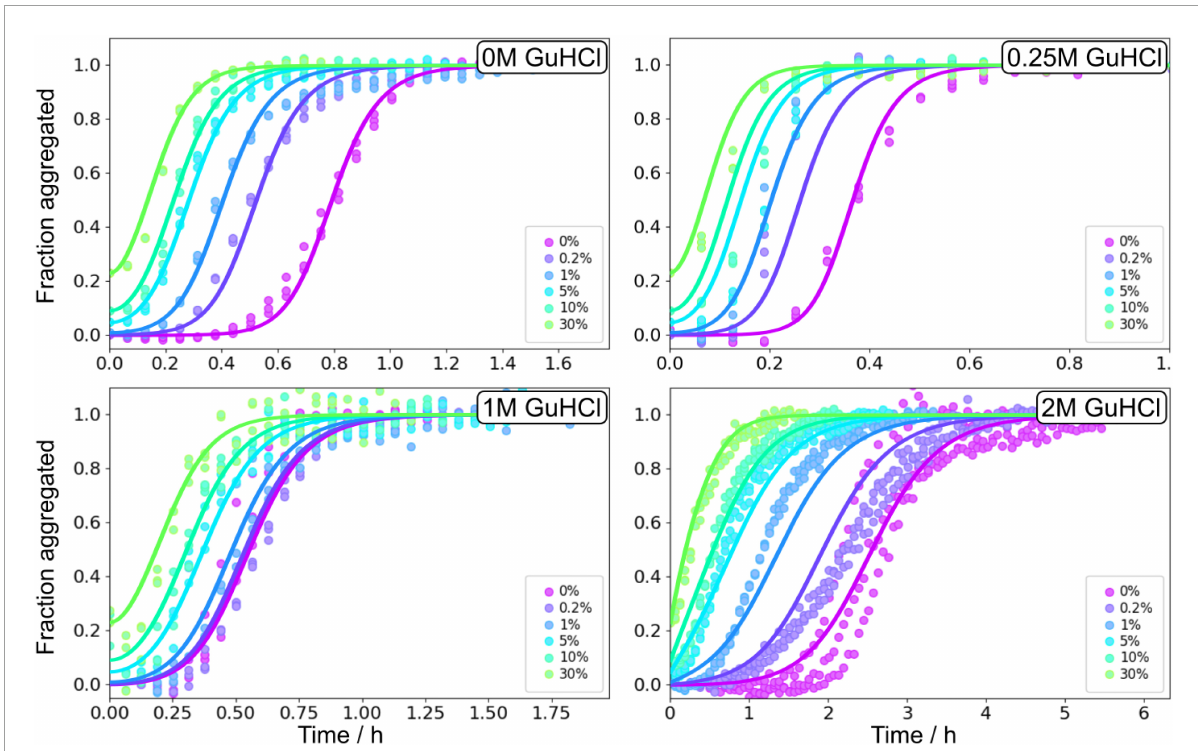
FIGURE9 Seeding experiments in GuHCl. Normalised ThT fluorescence as a function of time for 3 µ M A β 42 in buffer, 0.25 M GuHCl, 1 M GuHCl, and 2 M GuHCl in 20 mM sodium phosphate, 0.2 mM EDTA, 0.02% sodium azide, pH 8.0. The samples were supplemented at time zero with seeds, prepared at the corresponding GuHCl concentration, at 0.2, 1, 5, 10, and 30% in monomer concentration units. The solid lines show fits to the data using the same model as for the unseeded data with n 2 , n c , and K M , were fixed to the values determined in the unseeded conditions, whereas k n , k + , and k 2 were globally fitted over the six seed